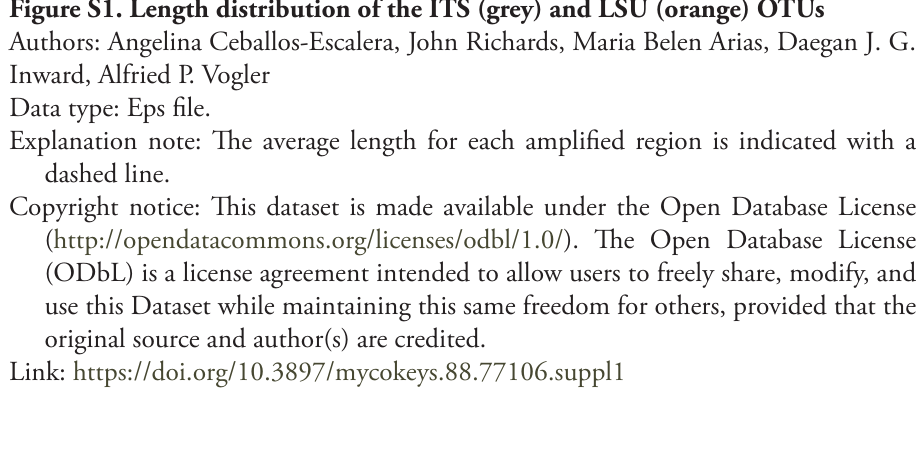
Figure S1. Length distribution of the ITS (grey) and LSU (orange) OTUs Authors: Angelina Ceballos-Escalera, John Richards, Maria Belen Arias, Daegan J. G. Inward, Alfried P. Vogler